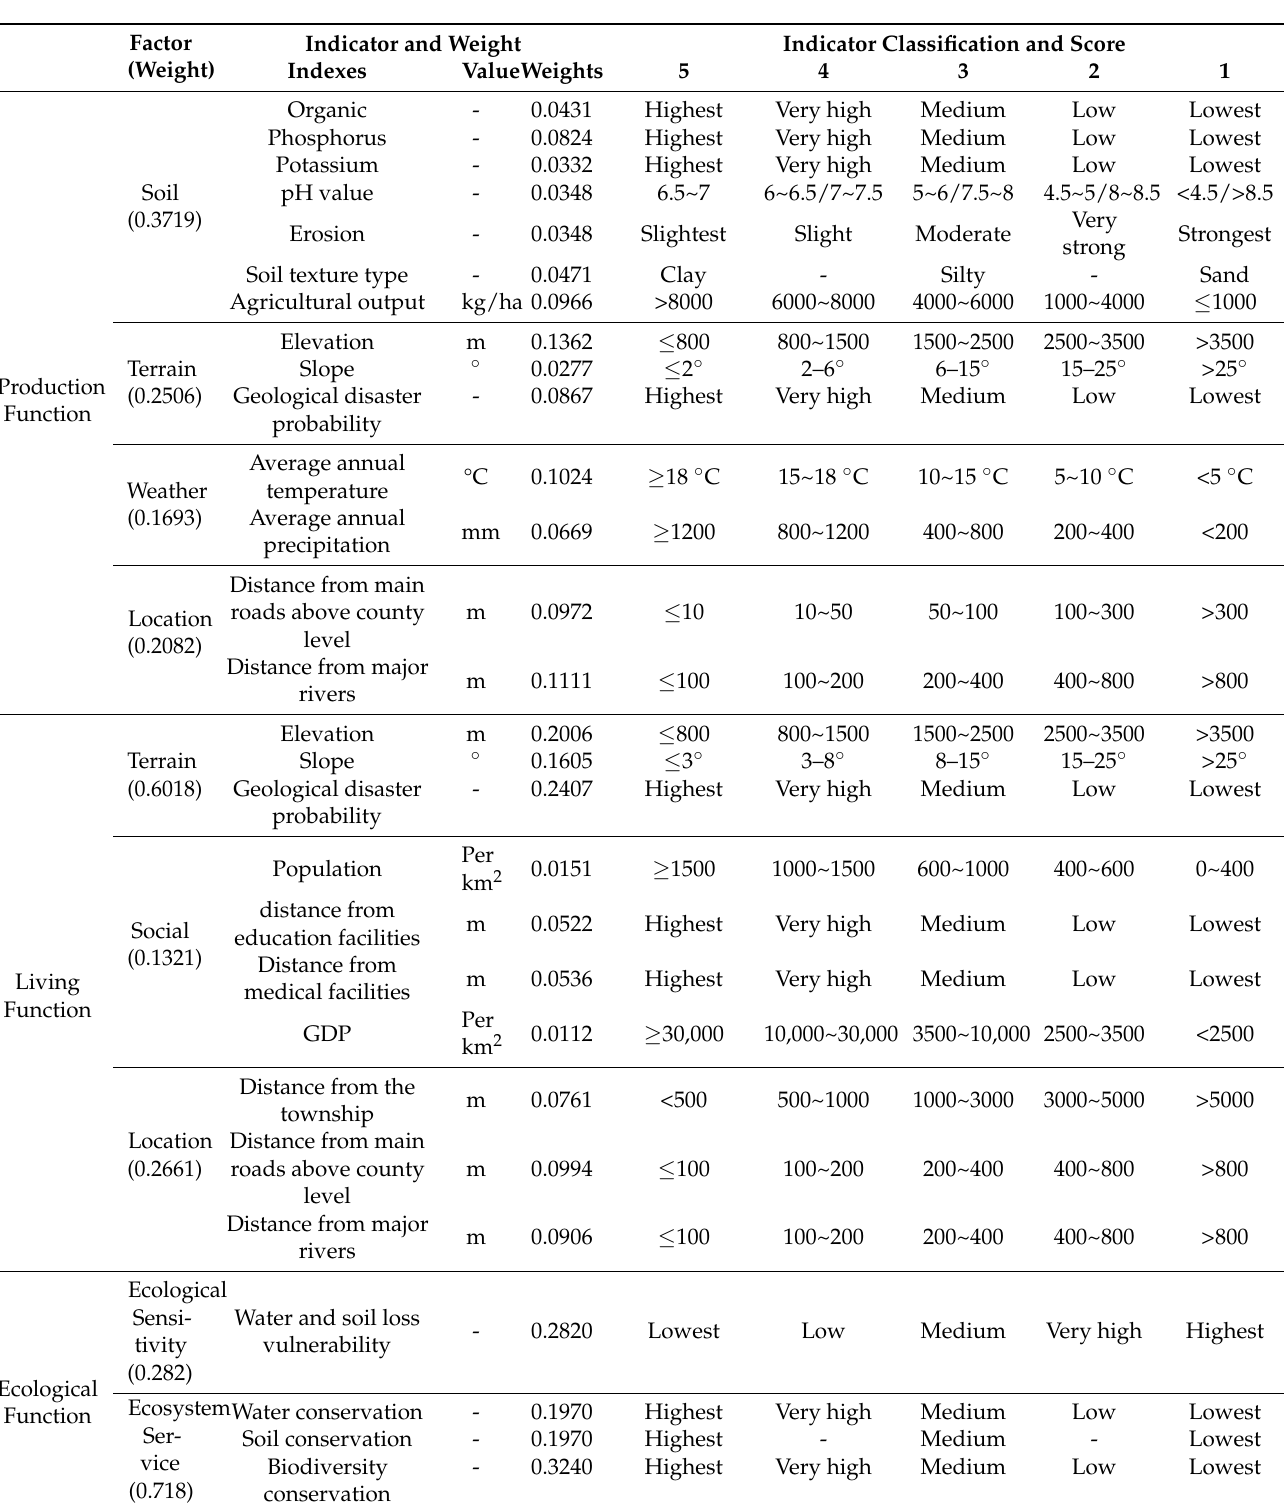
Table 1. Production–living–ecological function evaluation